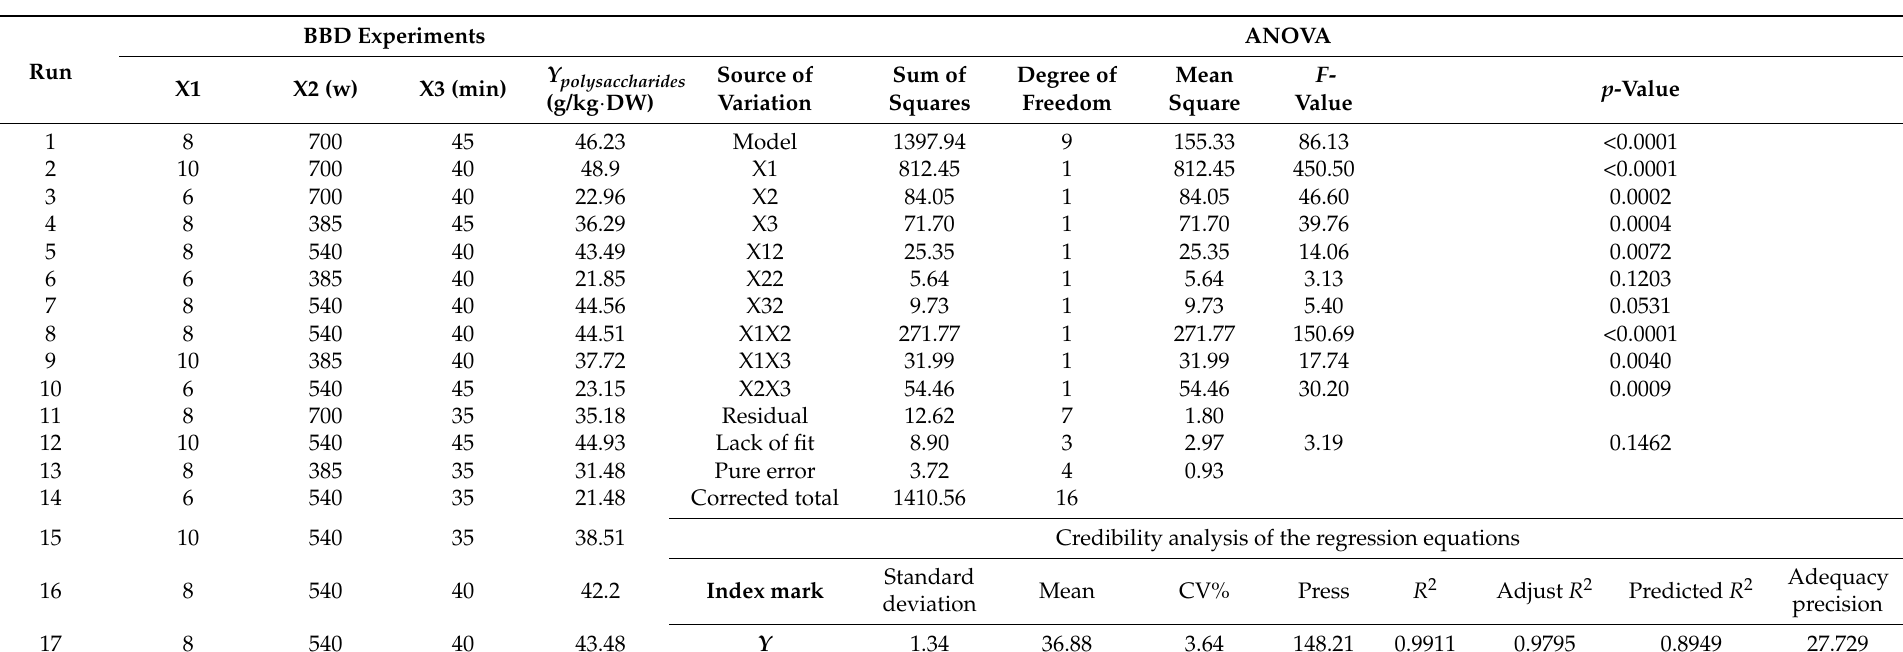
Table 2. Box-Behnken design (BBD) with experimental value for a total yield of polysaccharides (g/kgDW), analysis of varance (ANOVA) fo response surface quadratic